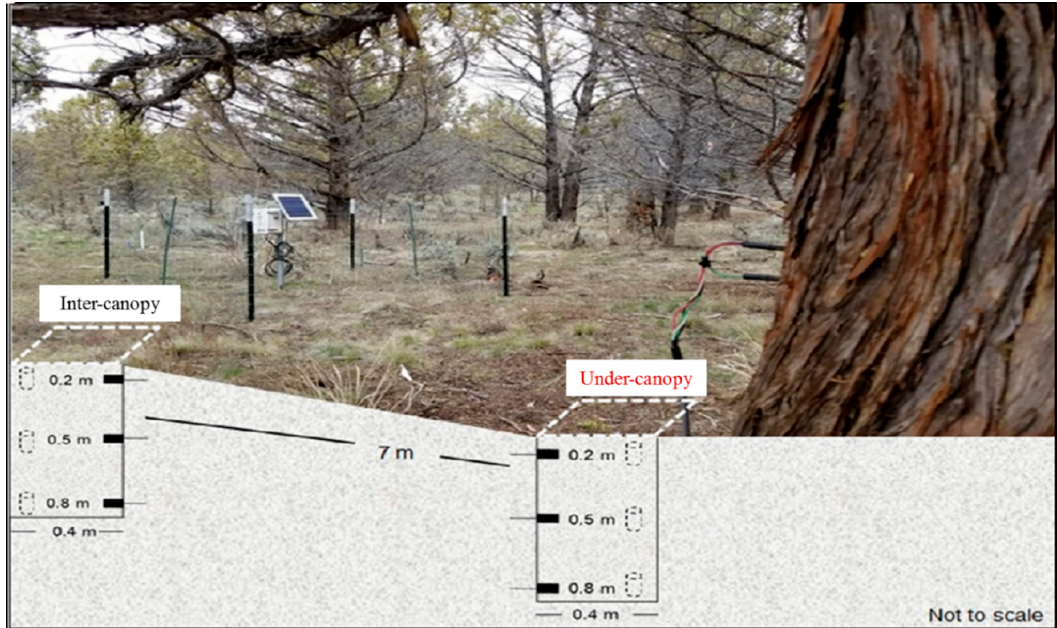
Figure 2. Schematic illustrating soil moisture sensor placement, soil sampling depth at under-canopy and inter-canopy locations, and a thermal dissipation probe installation for transpiration measurement in the valley location in Jensen WS.